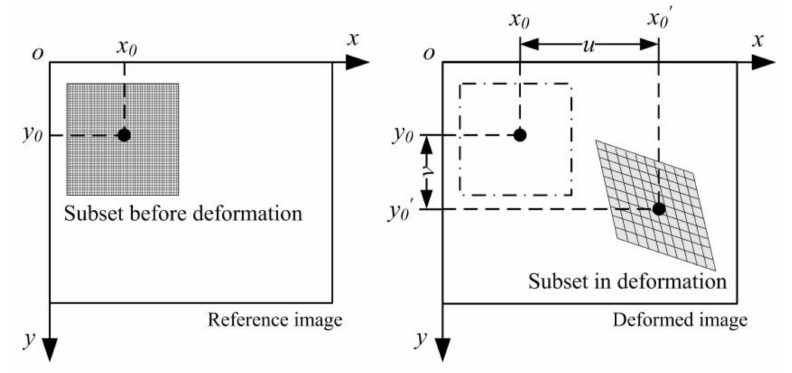
Figure 1. Schematic diagram of the subset in local DIC